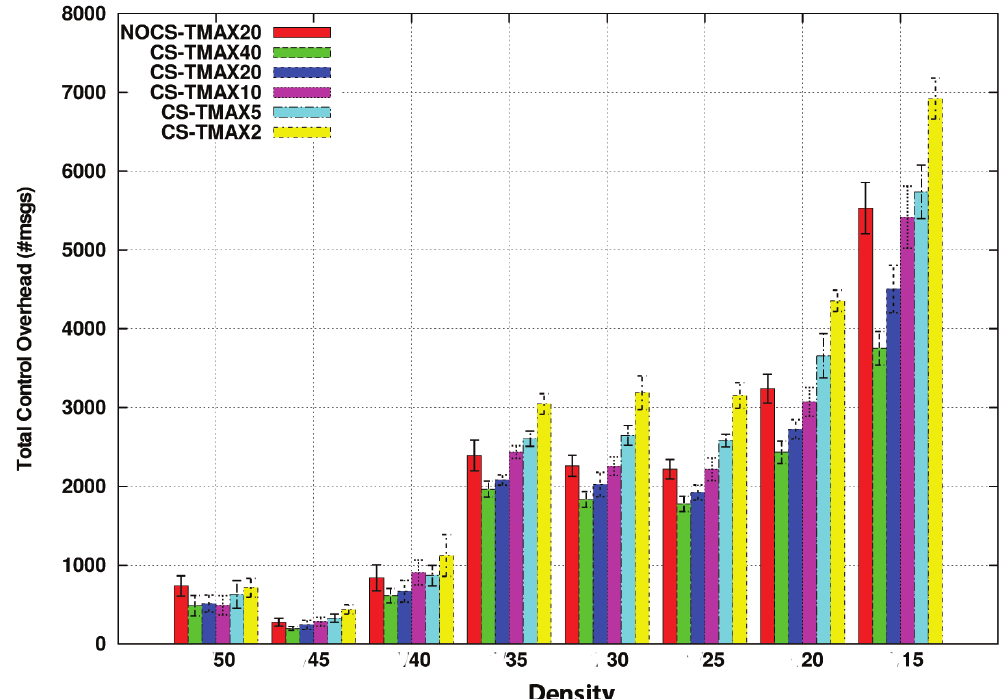
Figure 14. TMAX impact onto the overhead without accumulation.